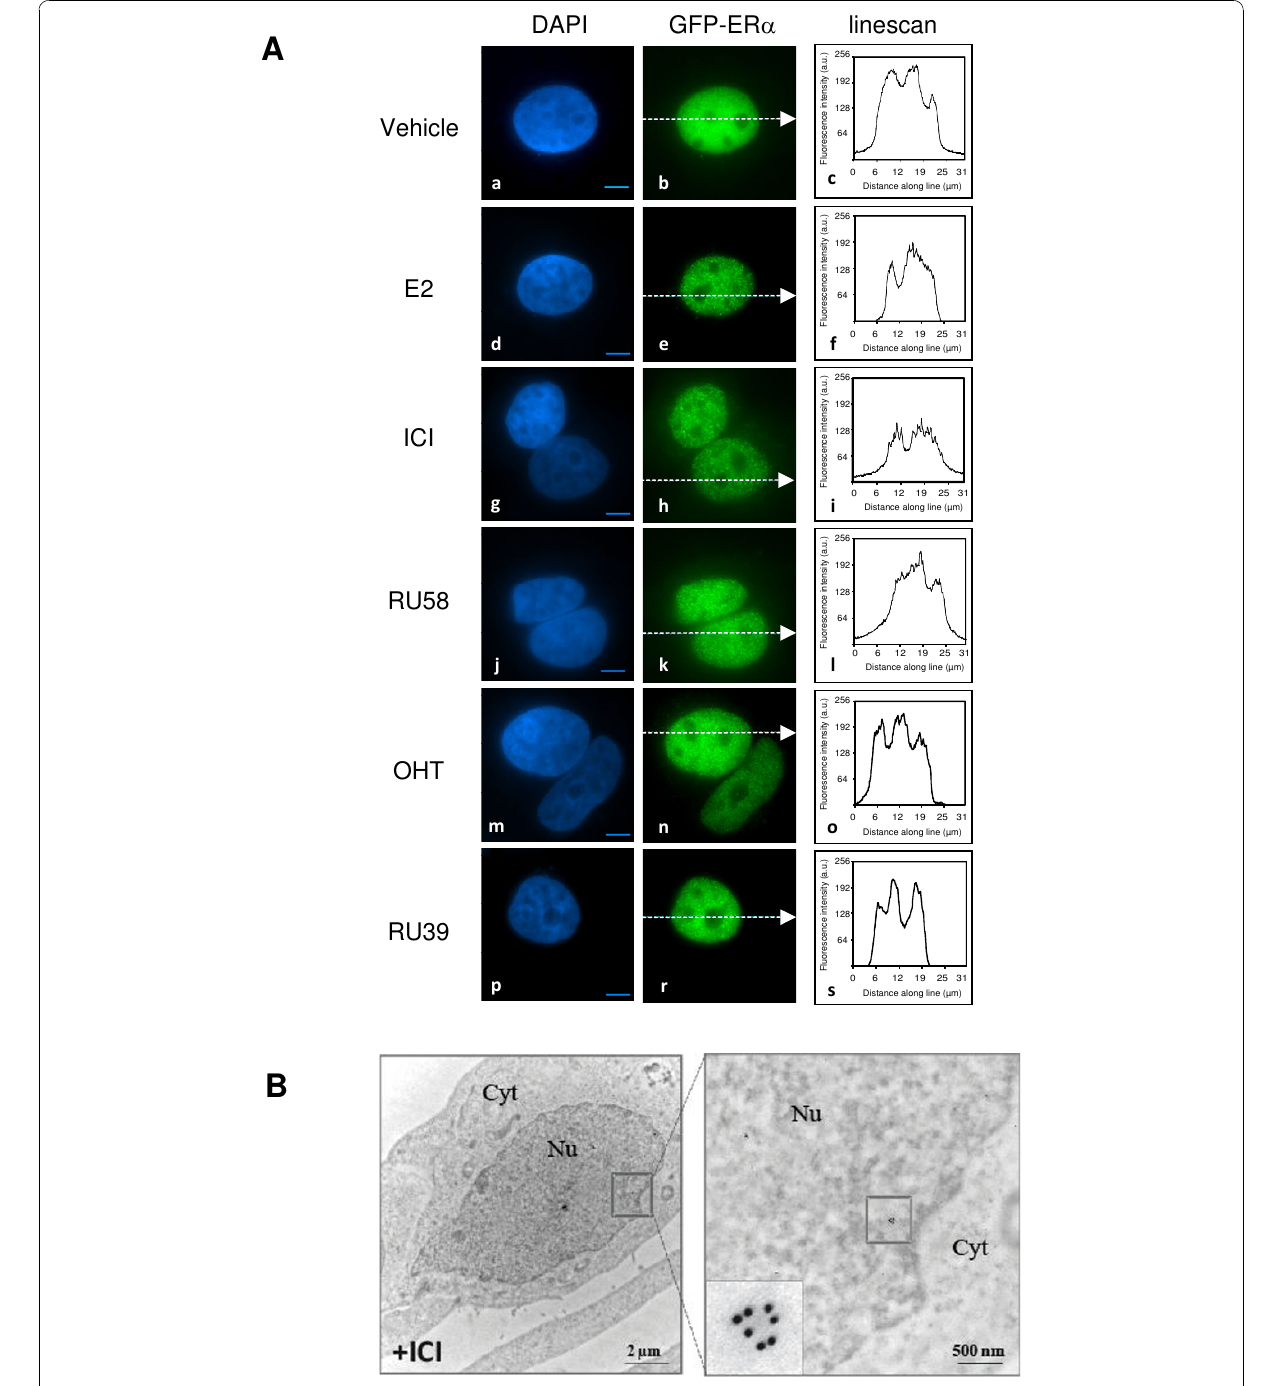
Figure 3 Estrogen, SERDs and SERMs induce distinct intracellular behavior of ER a . A) SK19 cells were incubated for 1 h with E2 and different anti-estrogens (SERDs or SERMs), fixed, stained with DAPI and examined by fluorescence microscopy using an Olympus IX-81 inverted microscope. GFP-ER a forms intranuclear foci in the presence of 10 nM E2, 1 μ M RU58 and 1 μ M ICI, but remains uniformly distributed in the nucleus after addition of 1 μ M OHT and 1 μ M RU39. Linescans indicate relative fluorescence intensities in the cytoplasm and the nucleus in the cells imaged using identical parameters. Pictures are representative of at least three independent experiments. Bar, 5 μ m. B) Representative electron micrograph of MCF-7 cells treated with 1 μ M ICI for 1 h. Inset indicates formation of ER a clusters in the nucleus after ICI addition. Bar, 2 μ m and 500